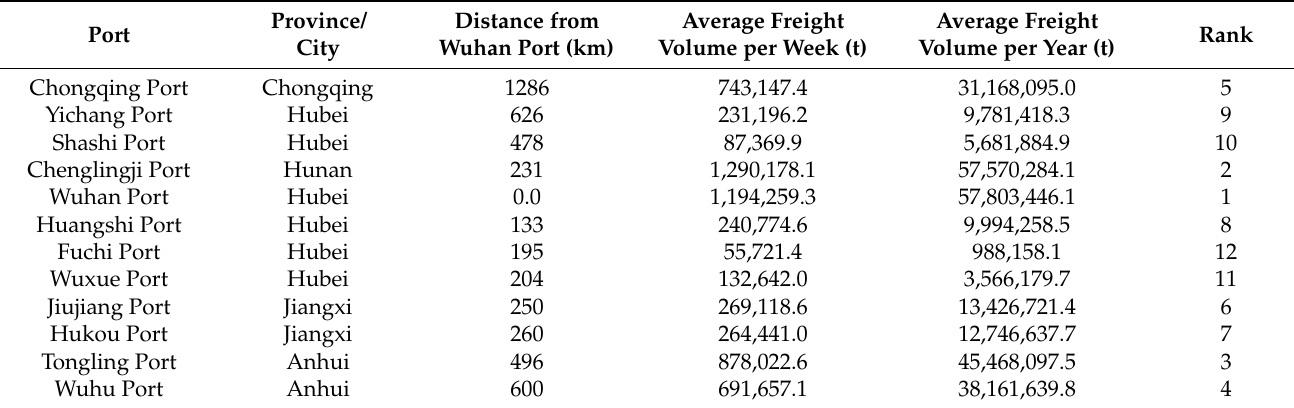
Table 1. Port information and freight volume statistics.